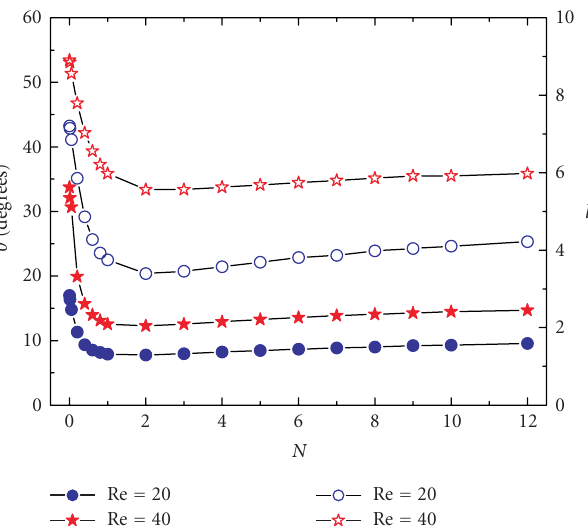
Figure 4.4 . Dependence of separation angle θ (open symbols with left y -scale) and the separation length l (closed symbols with right y -scale) on the interaction parameter N .